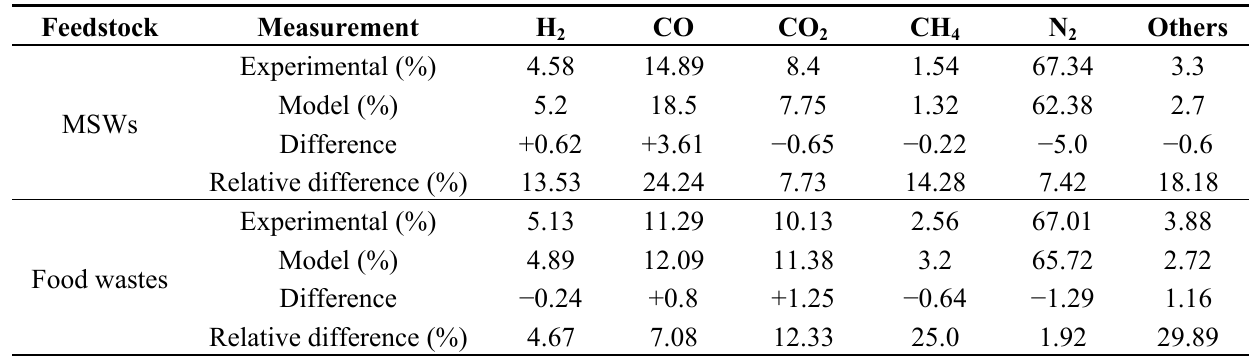
Table 3. Experimental and simulation results for